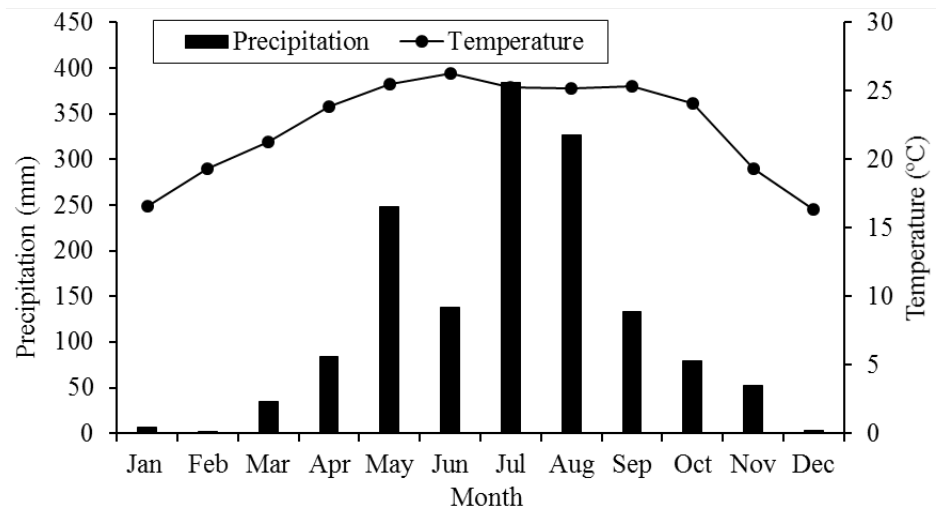
Figure 1. Measured monthly precipitation (mm) and temperature (°C) at the study site.